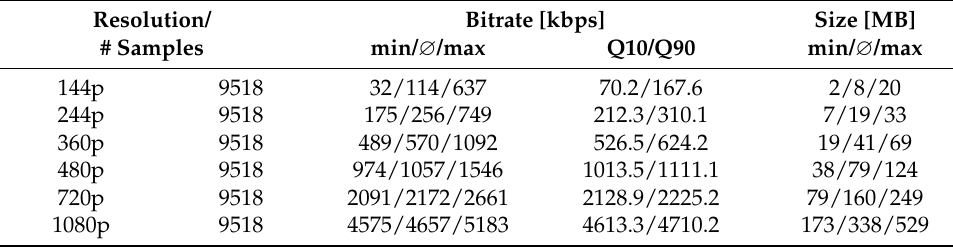
Table 2. Feasibility study: artificially generated video content; video duration: